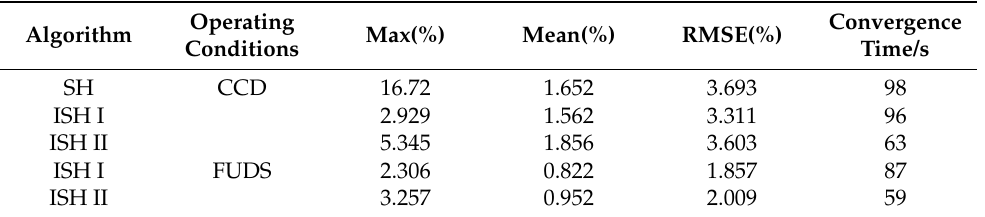
Table 3. SOC estimation errors analysis under different SH